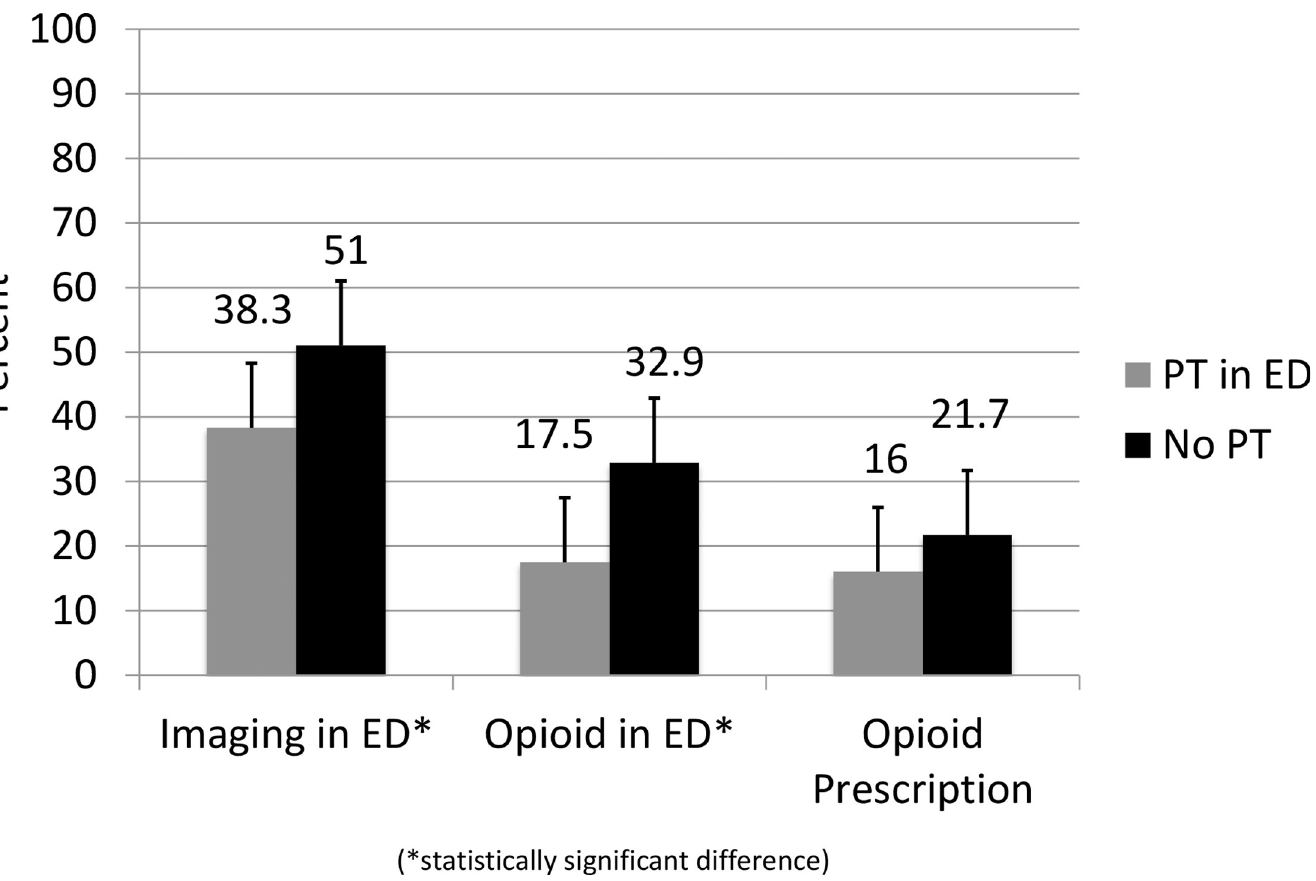
Fig 1. Imaging and opioid administration